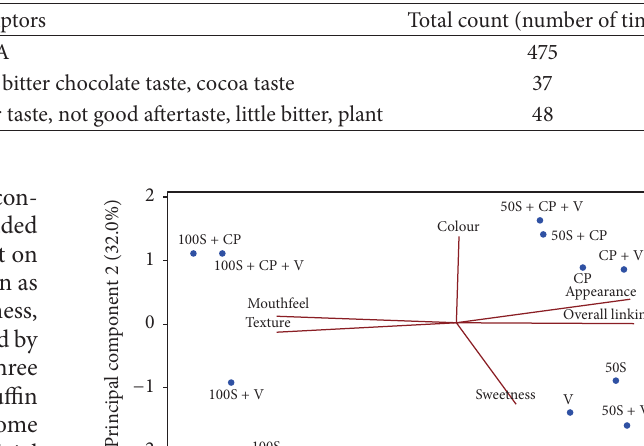
Table 6: Panellist descriptors and frequency of aftertaste in muffin products.